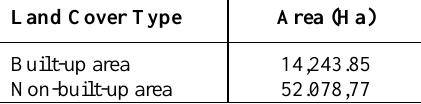
Table 2. Land cover area in